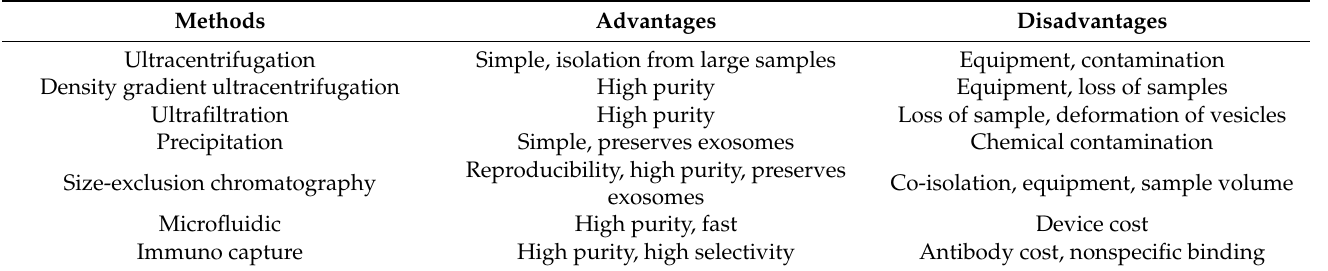
Table 1. Methods used for purification of